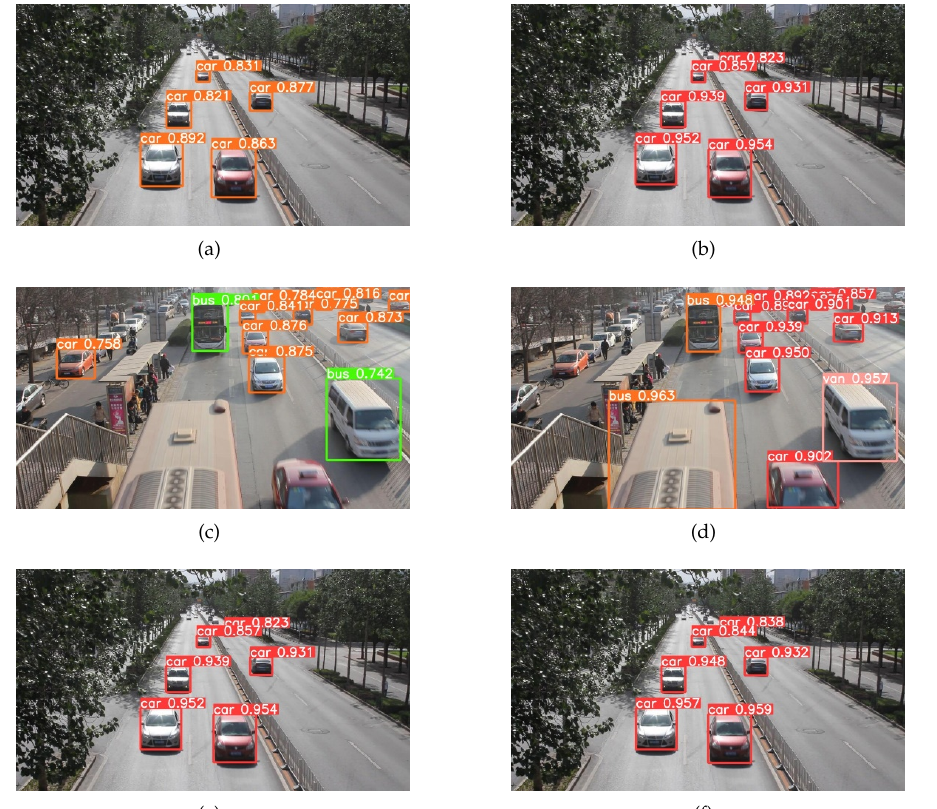
Figure 12. The visual detection results of the YOLOv5s and the YOLOv5-NAM